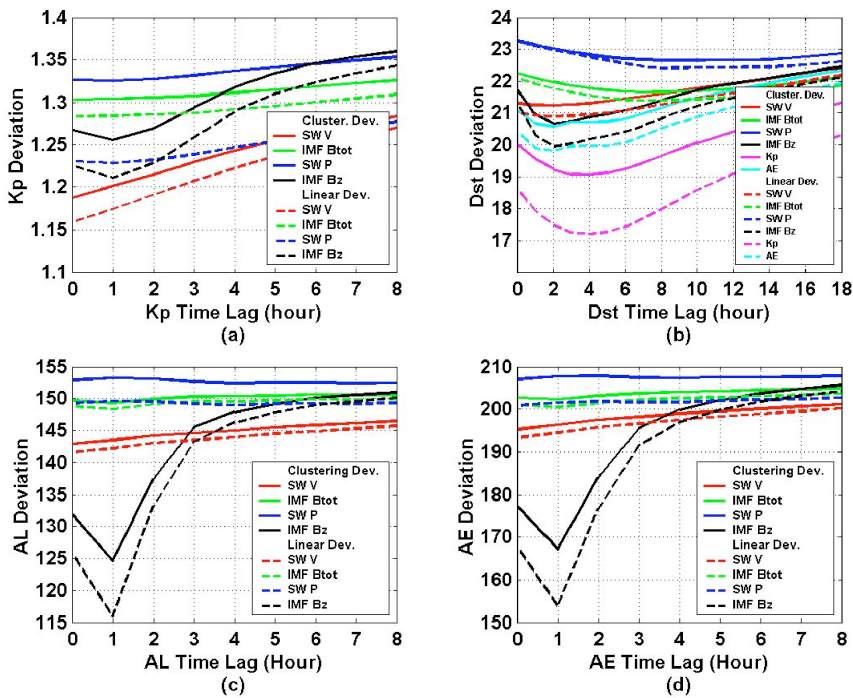
Fig. 4. Panels (a–d) show the total clustering deviations <σ> c (solid color lines) and piecewise-linear deviations <σ> p (dashed color lines) as a function of time lag of K p , D st , AE , and AL , respectively. The time lag at which a given response index has the minimum deviation indicates the natural response time of that index to the corresponding input. Panel (b) indicates that D st also responses to 3-h K p with a 2–5h